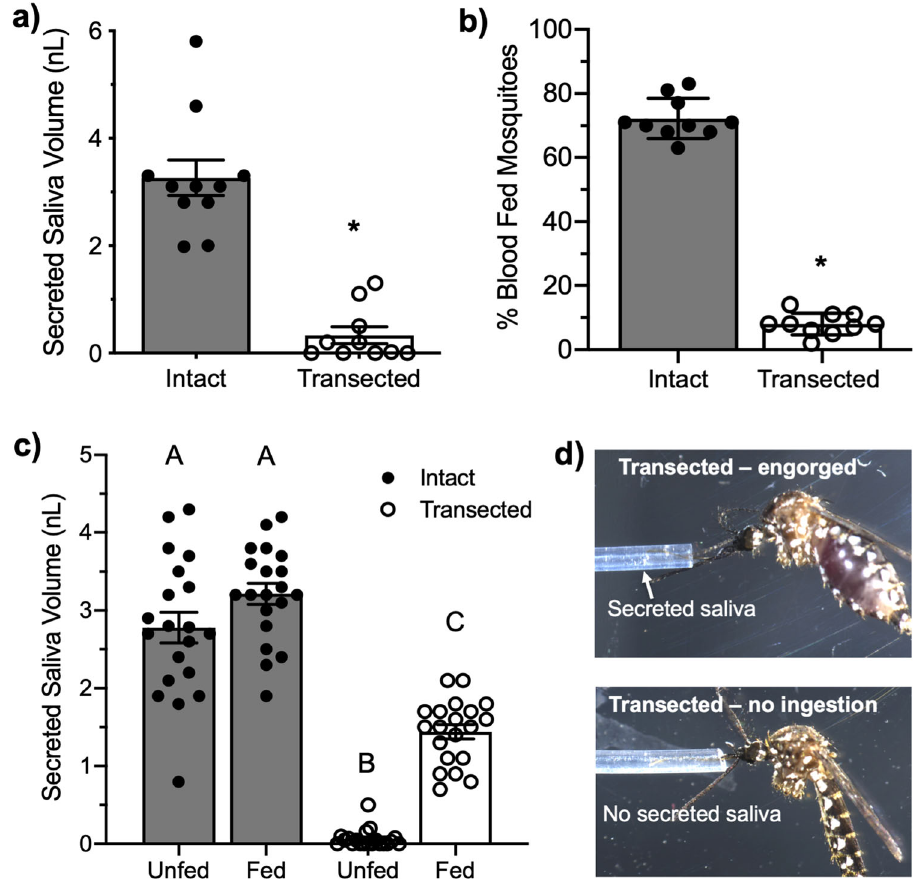
Fig. 1 Relevance of salivary gland function to the blood-feeding ability of A. aegypti . a Secreted saliva from intact (control) or transected mosquitoes after DA exposure where bars represent mean ( n = 5, 10 individuals per replicate) and error bars represent SEM. b Blood-feeding ef fi cacy of A. aegypti after microsurgery to transect the salivary duct where bars represent mean ( n = 10) and error bars represent SEM. For panels, a , b , asterisks represent statistical signi fi cance at P < 0.001 as determined by the unpaired t -test. c Secreted saliva of individual mosquitoes that have intact (closed circles, gray bars) or transected (open circles, white bars) salivary ducts. The mosquitoes studied in the transected group were the same transected individuals used in blood- feeding assays shown in panel b and the unfed represents the group that attempted to feed with no ingestion and the fed group represents engorged mosquitoes. Bars represent mean ( n = 20 individuals) and error bars represent SEM. Bars not labeled by the same letter are signi fi cantly different from each other at P < 0.05 as determined by a one-way ANOVA with multiple comparisons posttest. d Representative images of saliva secretion from fed or unfed mosquitoes that underwent microdissection to transect the salivary duct showing blood-fed mosquitoes salivated (top panel) and no salivation from unfed mosquitoes (bottom panel). See Supplemental Data 1 for underlying